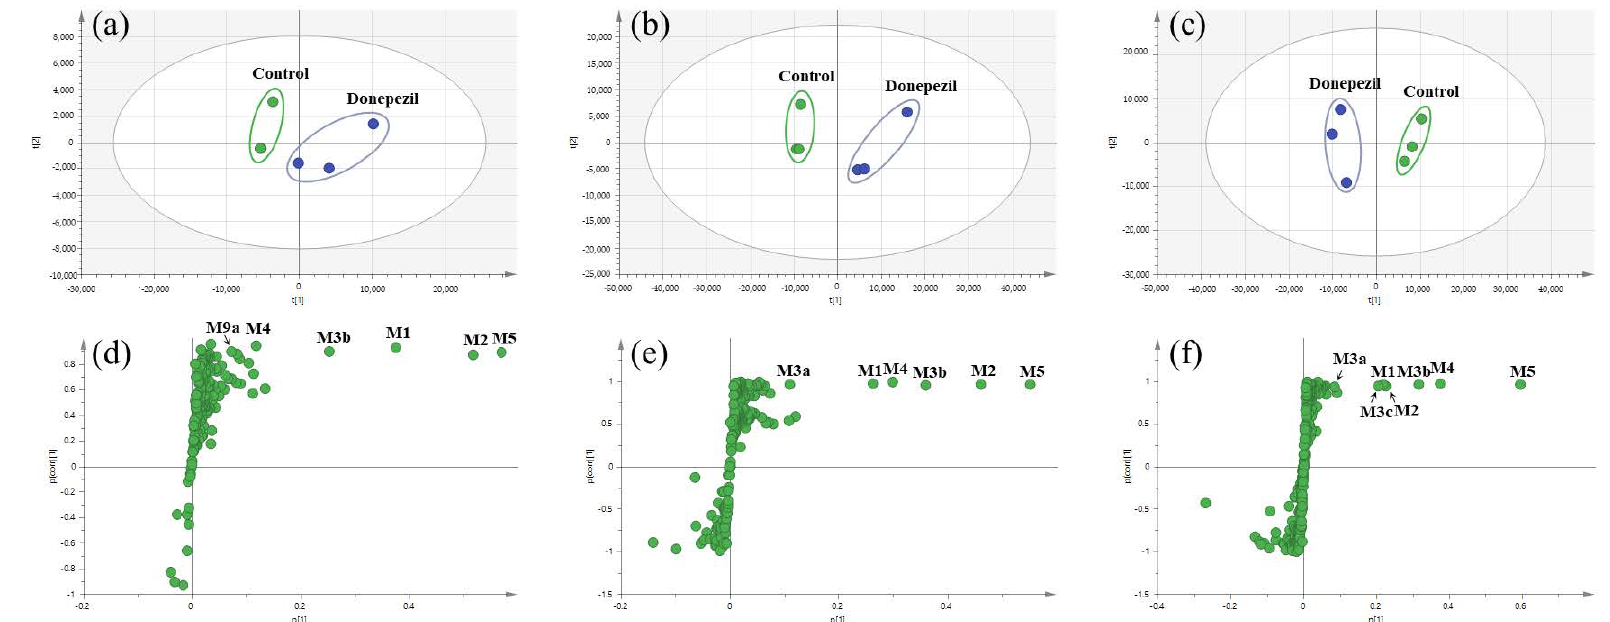
Figure 2. Multivariate analysis of donepezil metabolites in human liver microsomes (HLM) ( a ), mouse liver microsomes (MLM) ( b ), and rat liver microsomes (RLM) ( c ). Control groups were incubated in the absence of nicotineamide adenine dinucleotide phosphate reduced form (NADPH), and donepezil groups were incubated in the presence of NADPH. Score plots were generated by a principal component analysis based on the liquid chromatography–high resolution mass spectrometry data of human liver microsomes (HLM) ( a ), mouse liver microsomes (MLM) ( b ), and rat liver microsomes (RLM) ( c ). Loading S − plots were generated by an orthogonal partial least square − discriminant analysis (OPLS − DA) based on the liquid chromatography–high resolution mass spectrometry data of HLM ( d ), MLM ( e ), and RLM ( f ). The p [1] values represent the relevant abundance of ions, and p (corr) [1] values represent the interclass difference. Green dots on the S − plot represent variables (mass spectral data) which reflect the influence of each variable in the two groups (control vs. donepezil). Variables that are farthest from the origin in the S − plot are selected as potential donepezil metabolites. Identified metabolites were marked with abbreviations on the S − plot, and metabolite lists are given in Table 1. Data processing and model construction are described in the Materials and Methods.